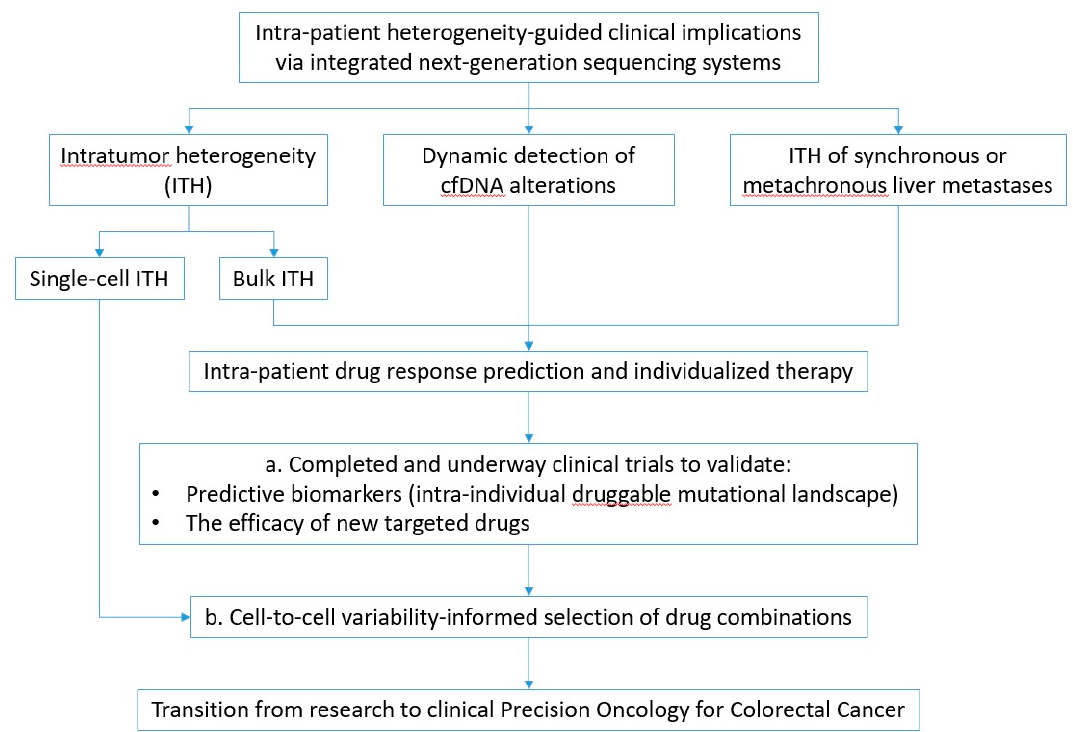
Figure 1. Putative clinical implications emerging from the breakthrough exploration of intra-patient intratumor and circulating heterogeneity . (a) Step-wise delineation of translational and